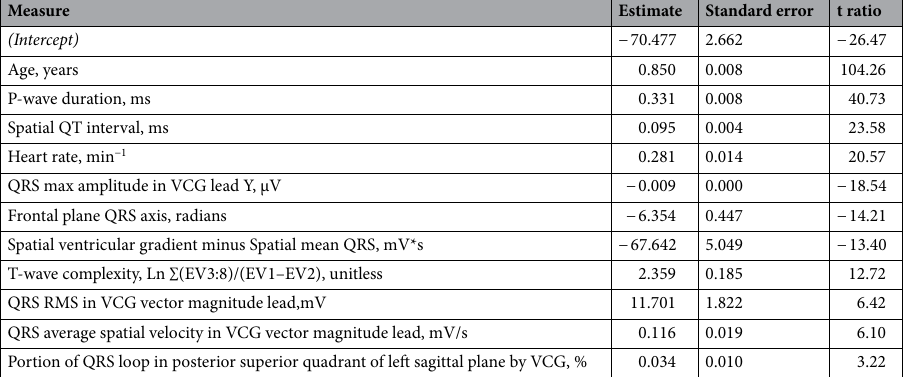
Table 4. Measures included in the 10-s ECG Heart Age for female subjects. Ln: Natural logarithm; EV: Eigenvalues; VCG: vectocardiographic; RMS: root mean square.